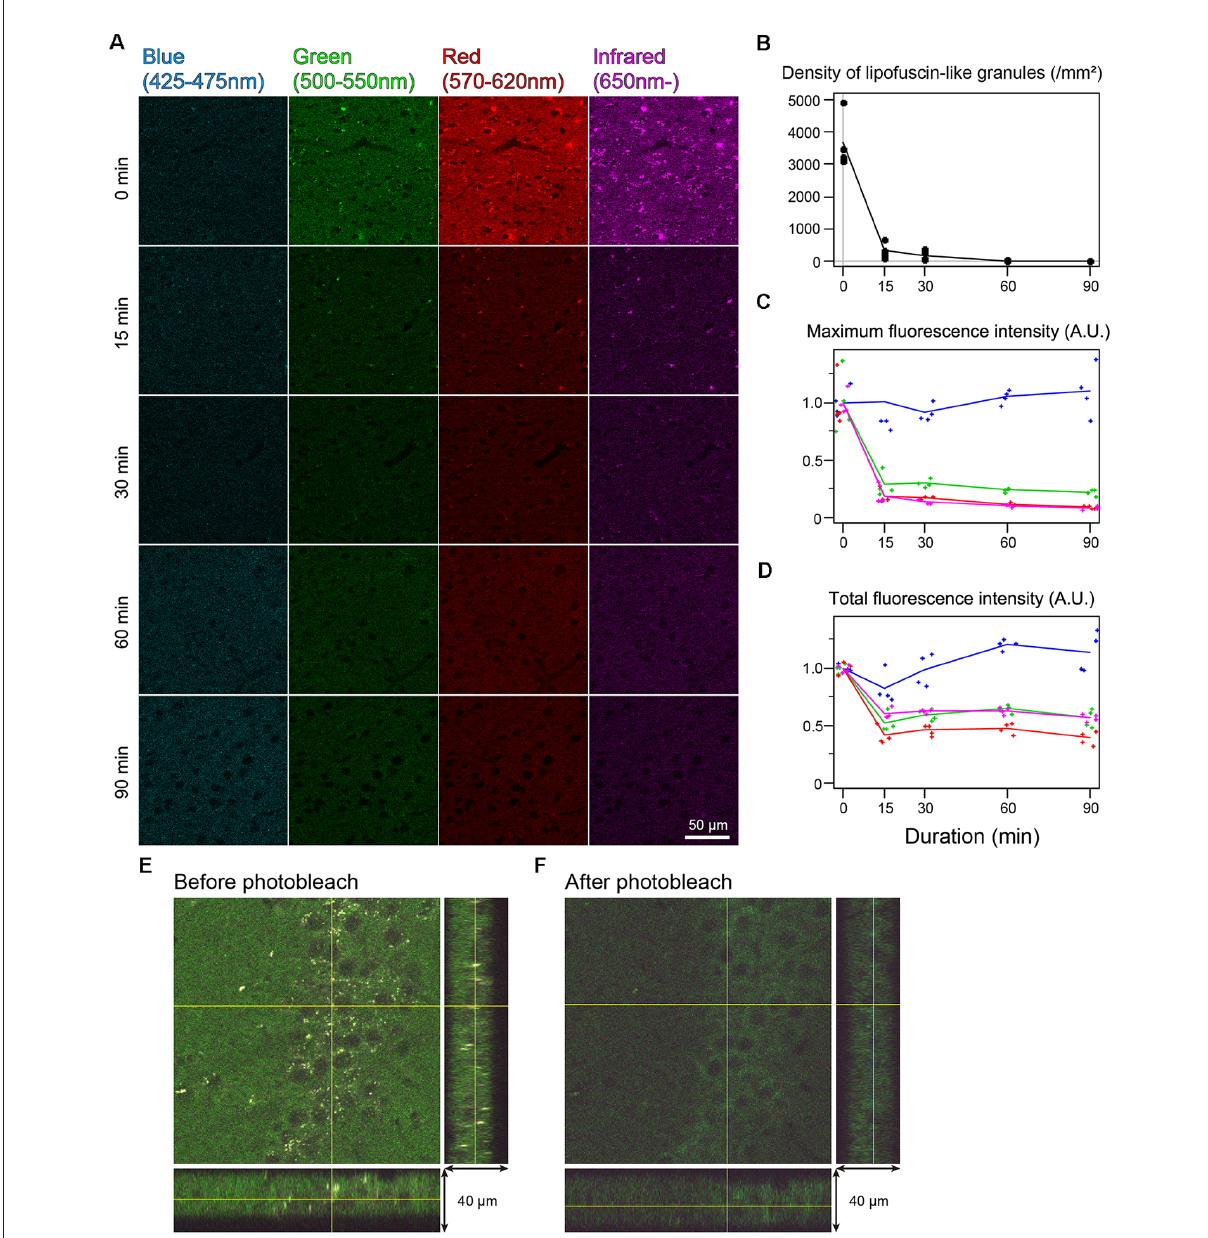
FIGURE2 Rapid quenching of autofluorescence in the mouse cingulate cortex by photobleaching using TiYO TM . (A) Change in autofluorescence according to the duration of photobleaching. Each row shows photos from different specimens. Scale bar: 50 µ m. (B) The density of lipofuscin-like granules. (C) Maximum fluorescence intensity. (D) Total fluorescence intensity. (B–D) Dots and lines represent the measured values and their means, respectively. Fluorescence intensities are shown as arbitrary units (A.U.). (E,F) Orthogonal views of the same 40 µ m-thick section before (E) and after photobleaching (F)